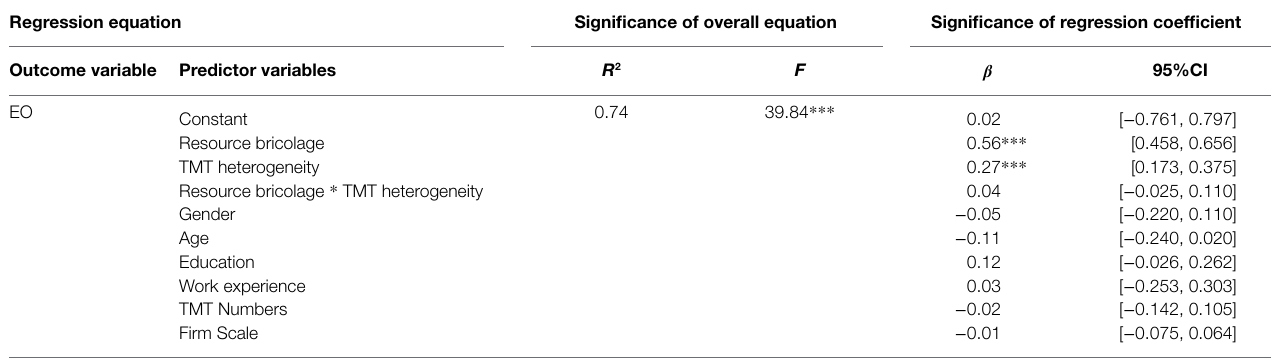
TABLE 3 | The moderating effect of TMT heterogeneity.